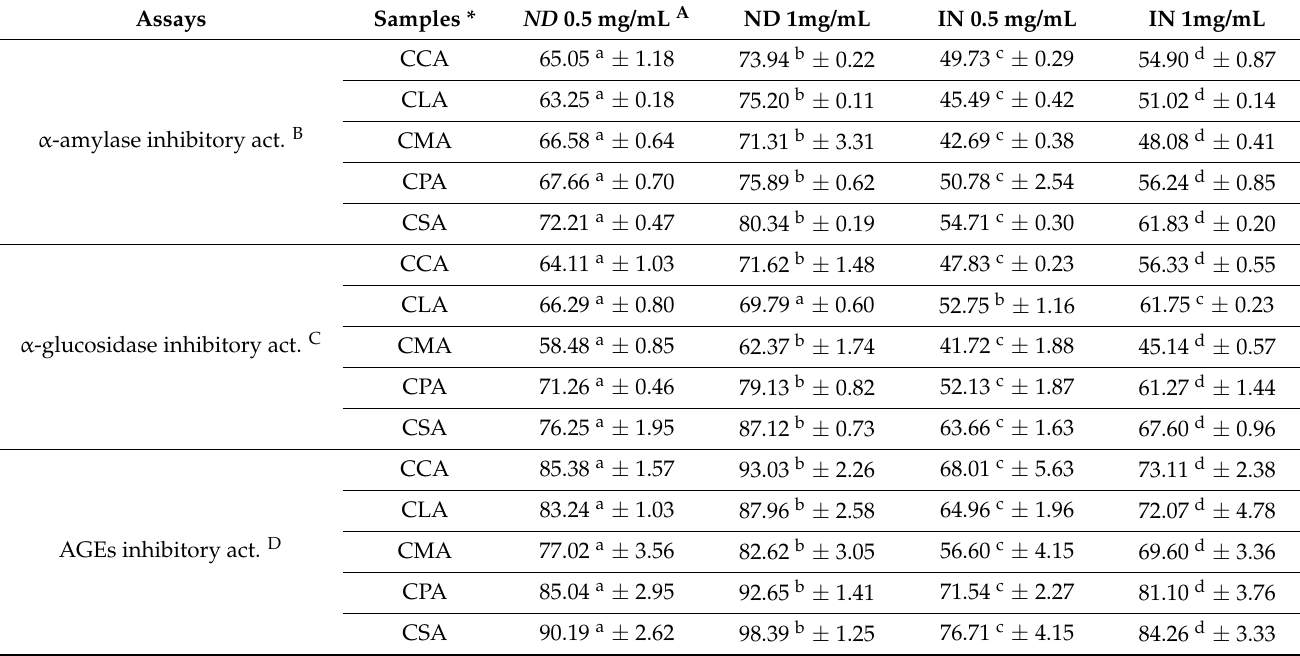
Table 4. Spectrophotometric determination of antidiabetic activities of Cistus